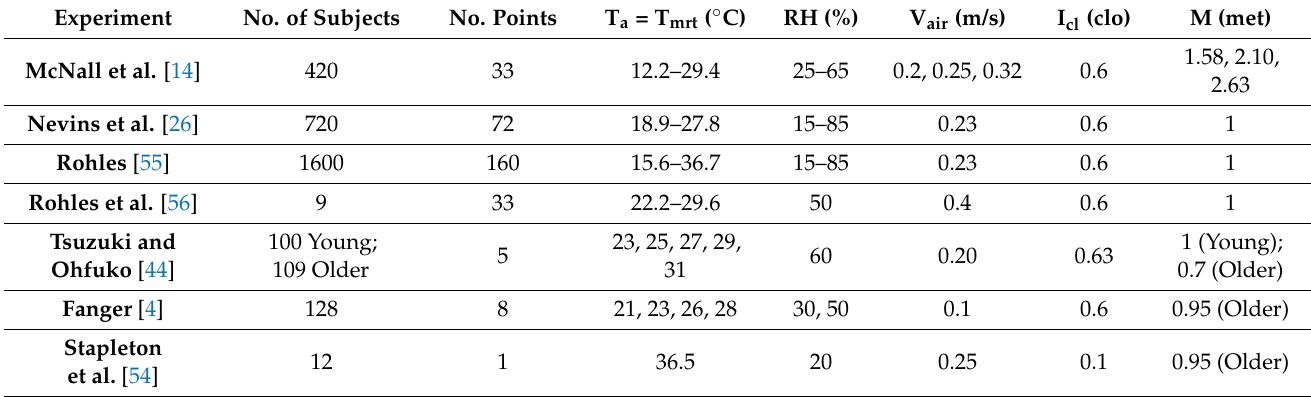
Table 1. Input data of the selected experiments.